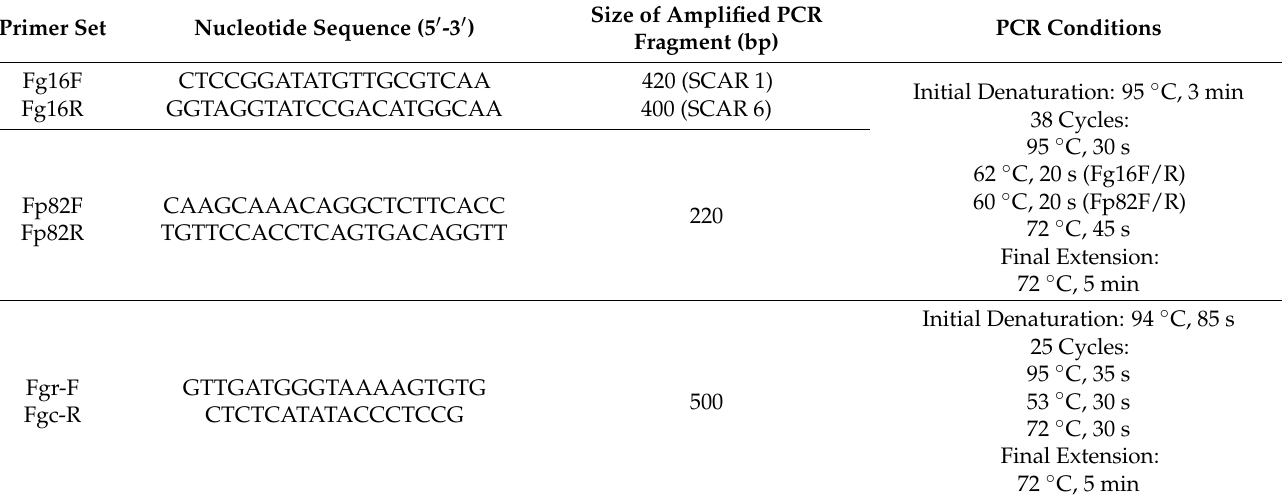
Table 1. Primer sets for the identification of Fusarium